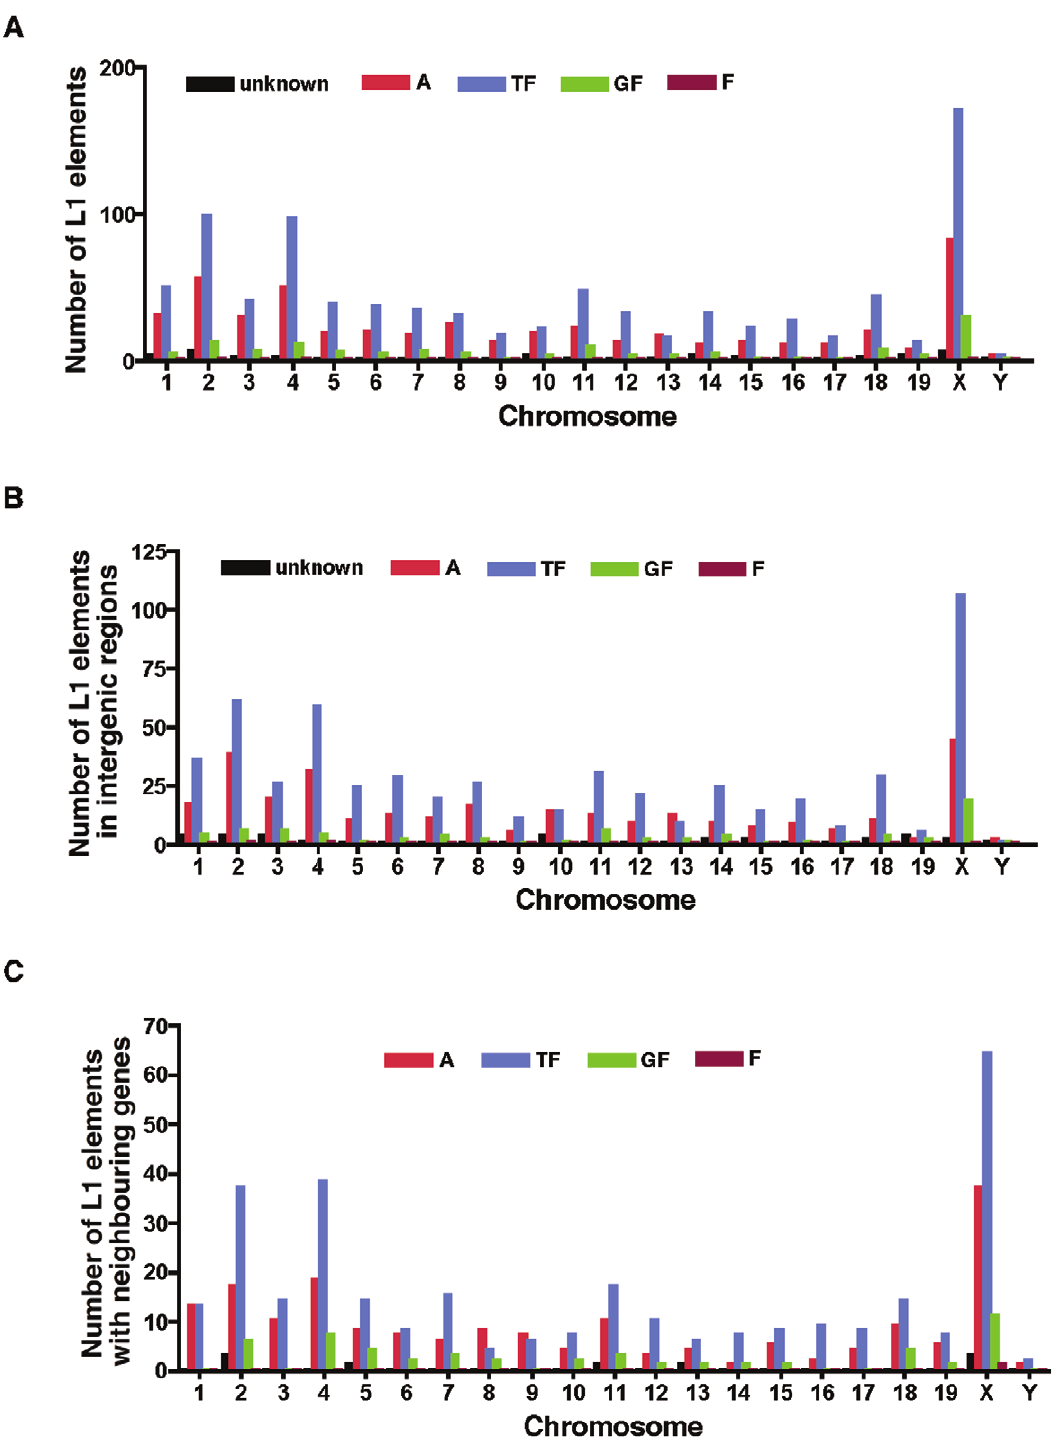
Figure 2. Genomic distributions of L1 elements and subfamilies. ( A ) Number of potentially active L1 elements (n=1,464) residing on individual mouse chromosomes. ( B ) Distribution profiles of L1 elements among subfamilies (n=953) located at intergenic regions, and ( C ) gene-rich regions of the mouse chromosomes having annotated neighboring genes in 100-kb windows surrounding the L1 elements (n=546). The frequency of L1 elements per chromosome was calculated by Chi-square test for trend ( x 2 =6.688, dt=1, p =0.0097).